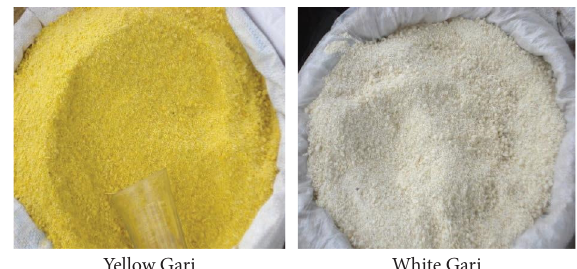
Figure 1: Yellow and white Gari found on market stalls in